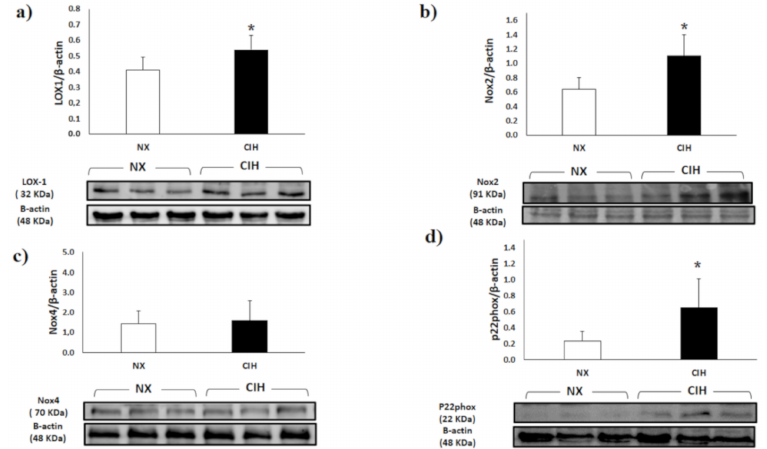
Figure 2. Expression of ( a ) Lectin-like oxidized low-density lipoprotein receptor-1 (LOX-1); ( b ) Nicotinamide adenine dinucleotide phosphate oxidase-2 (Nox2); ( c ) Nicotinamide adenine dinucleotide phosphate oxidase-4 (Nox4); ( d ) p22phox subunit (p22phox) expression in the right ventricle (RV) in the normoxia (NX); n = 10 and chronic intermittent hypobaric hypoxia (CIH); n = 10, groups, normalized by β -actin expression. Representative bands are shown. The values are the mean (x) ± standard error (SE). * p < 0.05: CIH group vs. NX